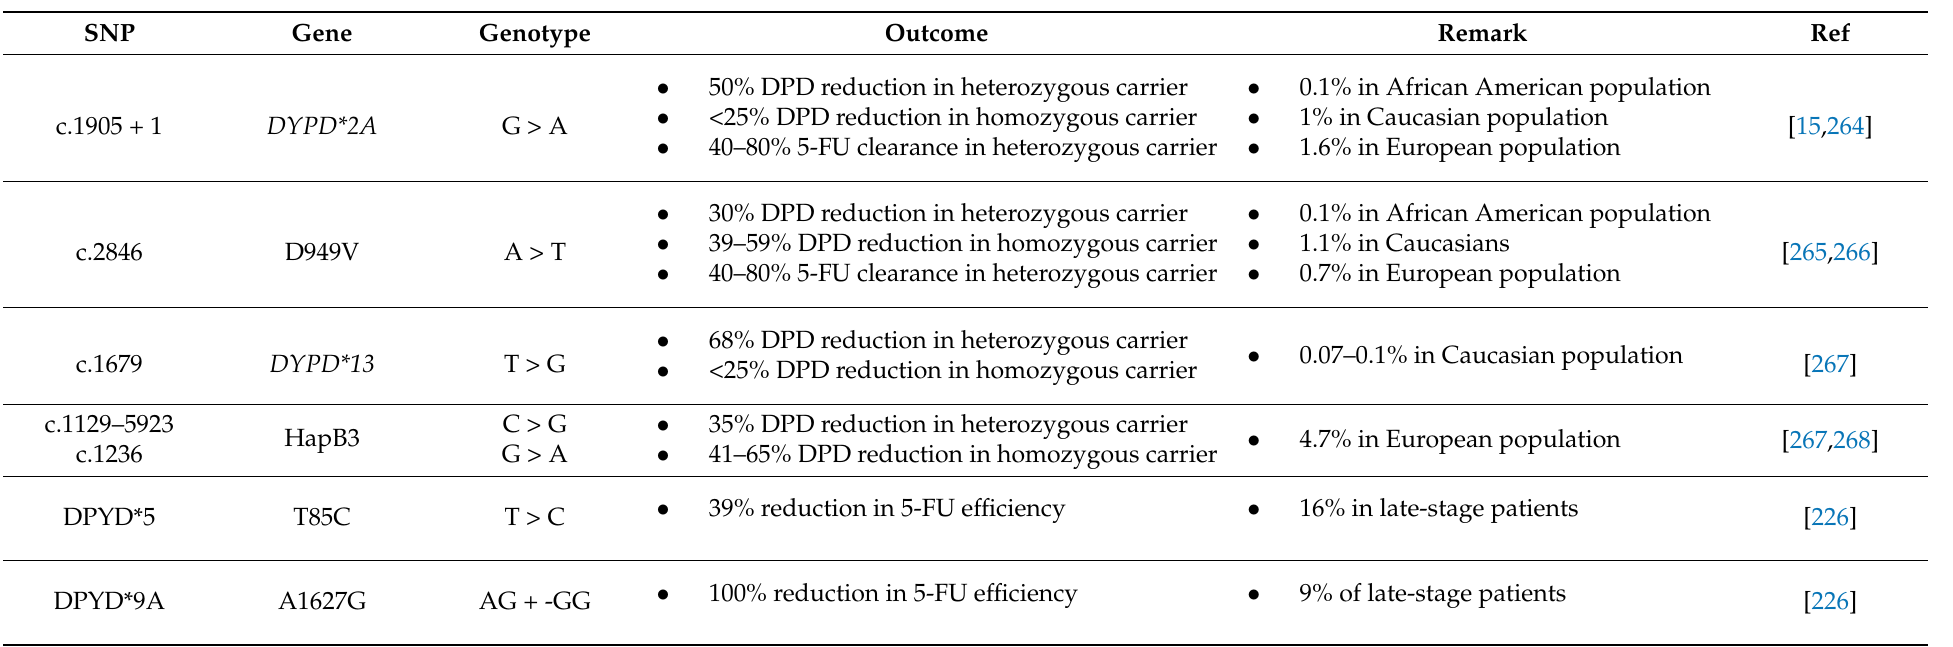
Table 3. Heterogeneity in DPD expression can be contributed by various single nucleotide polymorphisms (SNPs) that leads to differing 5-FU response outcome in colon cancer patients.